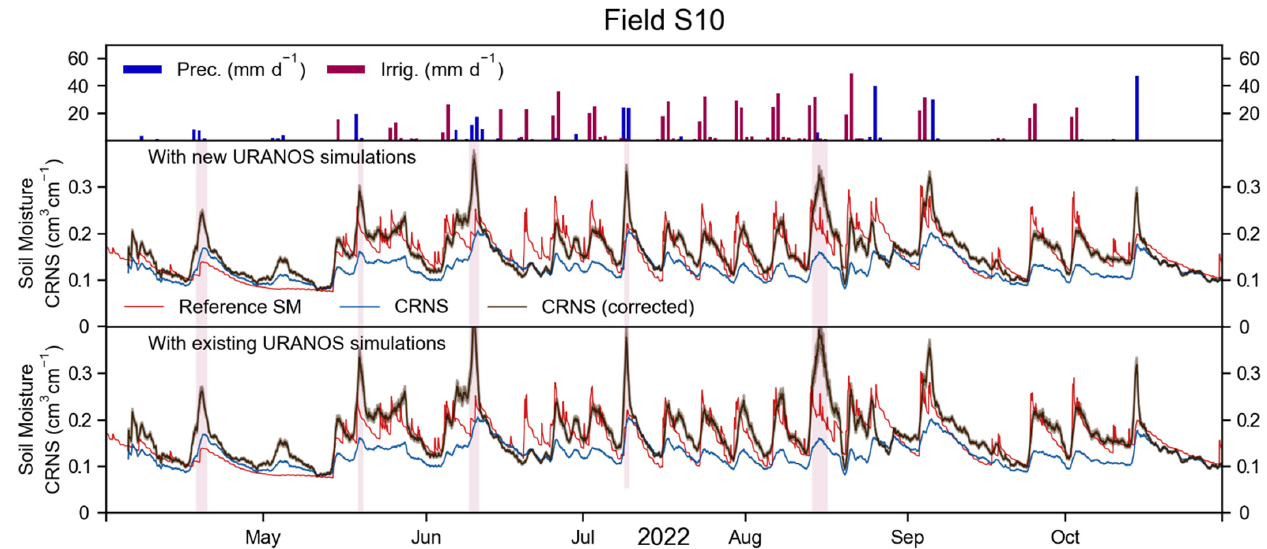
Figure A3. In the first panel precipitation and irrigation for field S10 during the 2022 irrigation period are provided. In the second panel, reference SM, standard CRNS-derived SM (blue line), and corrected CRNS-derived SM (black line) that used new URANOS simulations are shown. In the third panel, the use of existing URANOS simulations for the correction of CRNS-derived SM is shown.